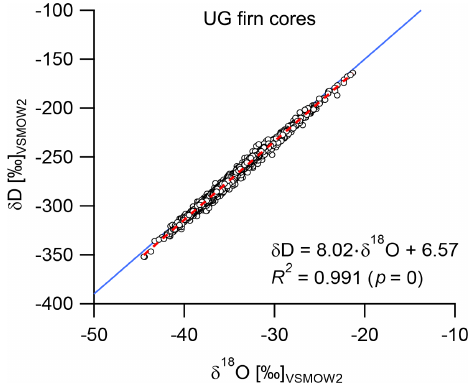
Figure 5. Composite co-isotopic relationship ( δ 18 O vs. δ D) based on all individual samples ( n = 2348; white dots) of the six firn cores from UG with the equation, the coefficient of determination ( R 2 ) and the p value ( p ) of the linear regression (red dashed line). The GMWL is indicated in blue. The composite co-isotopic relationship is referred to as the LMWL of the UG